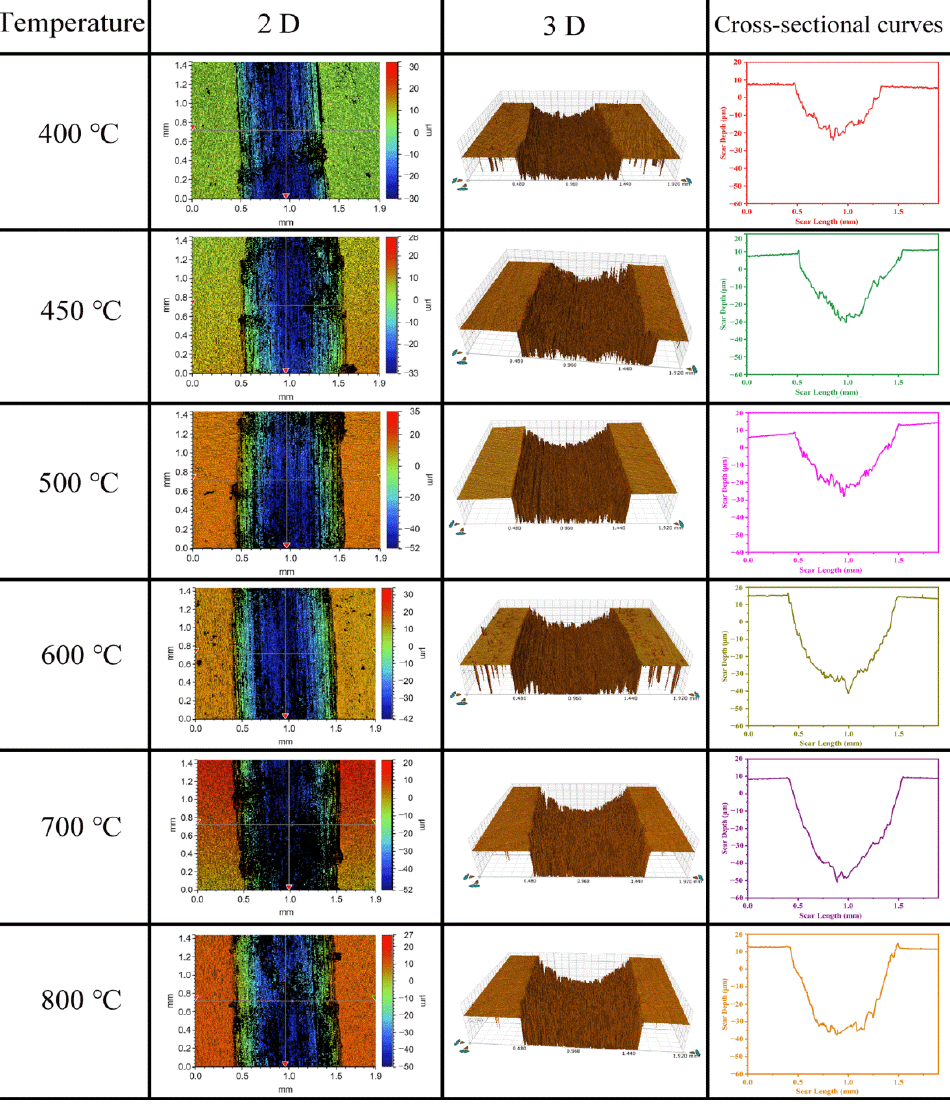
Figure 9. Two-dimensional and three-dimensional morphology of the annealed Zr – Ti – 8V alloys.